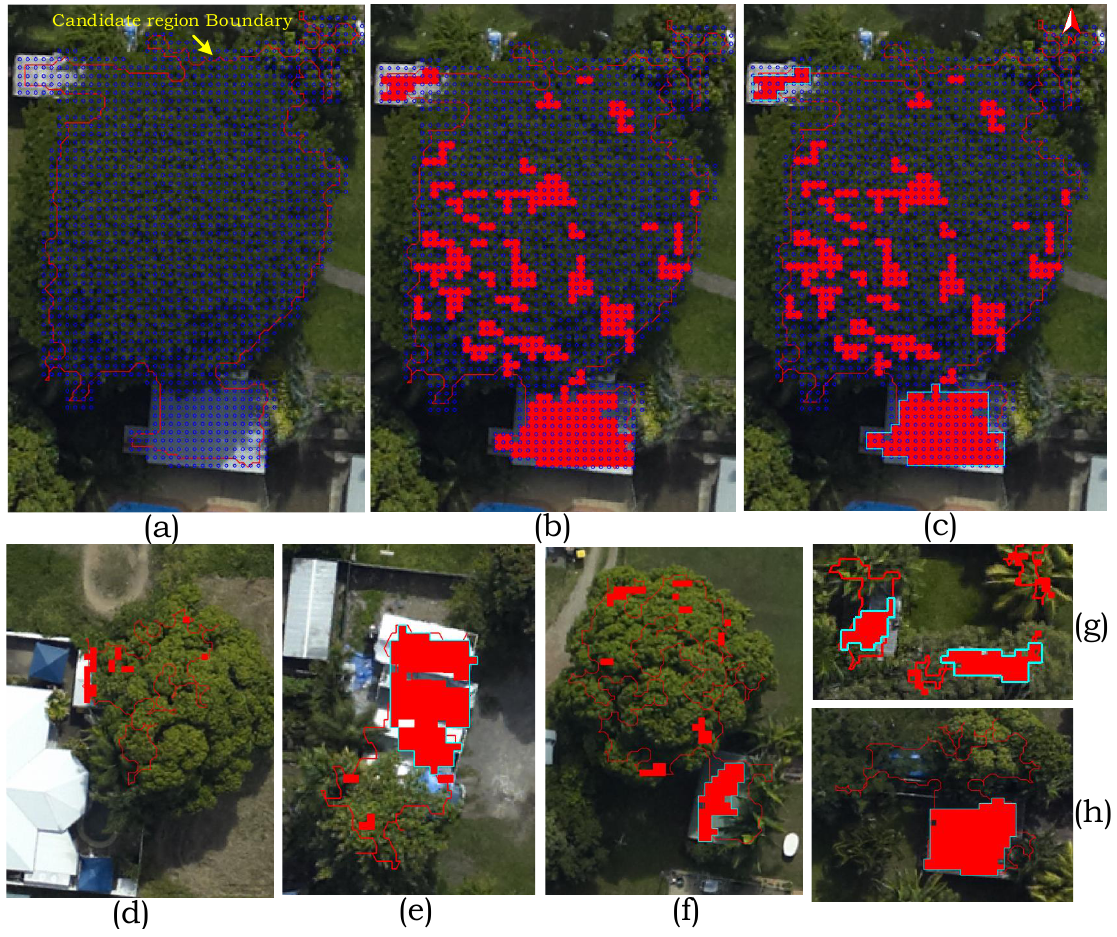
Figure 8. Cell clustering process: ( a ) Cells collection for a candidate region (4 blue holes correspond to a cell); ( b ) Clustered cells (red); ( c ) Clusters marked as buildings (cyan boundary) and; ( d – h ) Boundary delineation